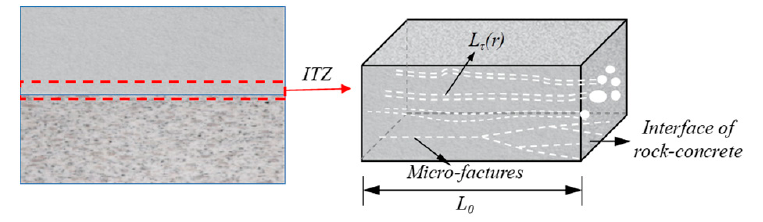
Figure 13. Schematic diagram of water transport in ITZ.